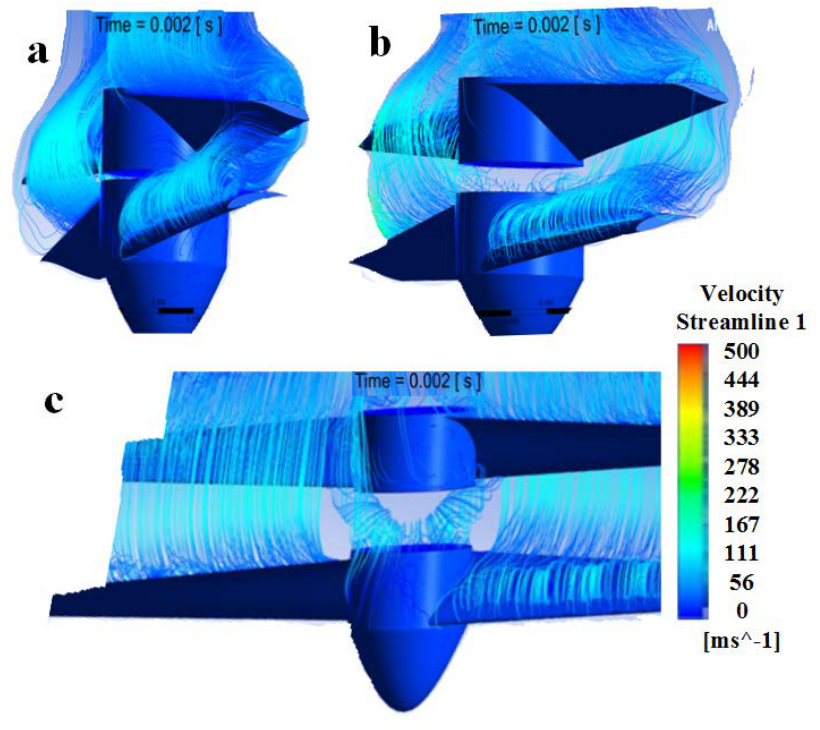
Figure 11. Velocity streamline at an axial distance of ( a ) 10 cm, ( b ) 14 cm, and ( c ) 17 cm.